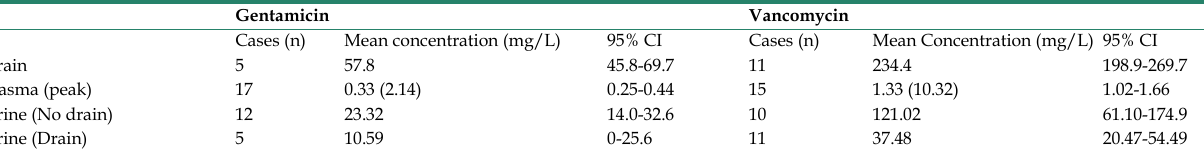
Table 2. Gentamicin and vancomycin concentrations in drain fluid, plasma and urine in 32 cases treated with a commercially available antibiotic carrier (CERAMENT™)